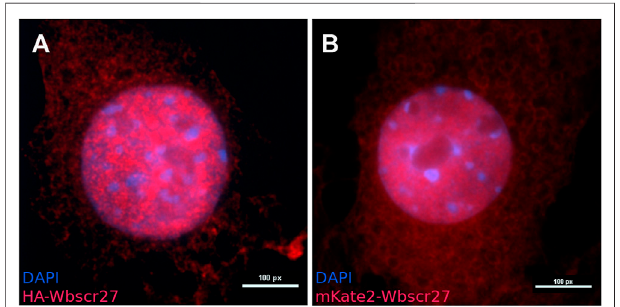
FIGURE 1 | The intracellular localization of WBSCR27 in NIH3T3 cells. (A) HA-WBSCR27; (B) mKate2-WBSCR27. The signal is present in both the cytoplasm and nucleus. The nucleus was visualized with